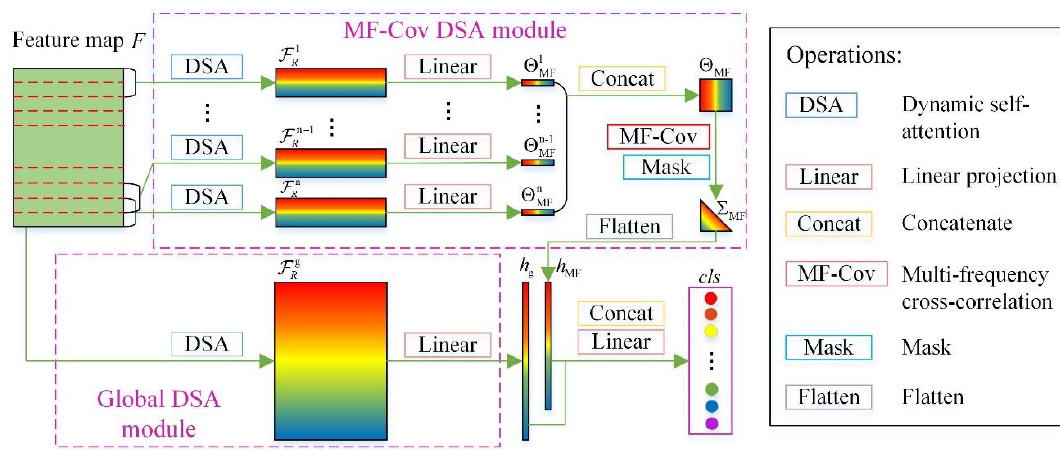
Figure 4. Idler fault diagnosis model based on dynamic